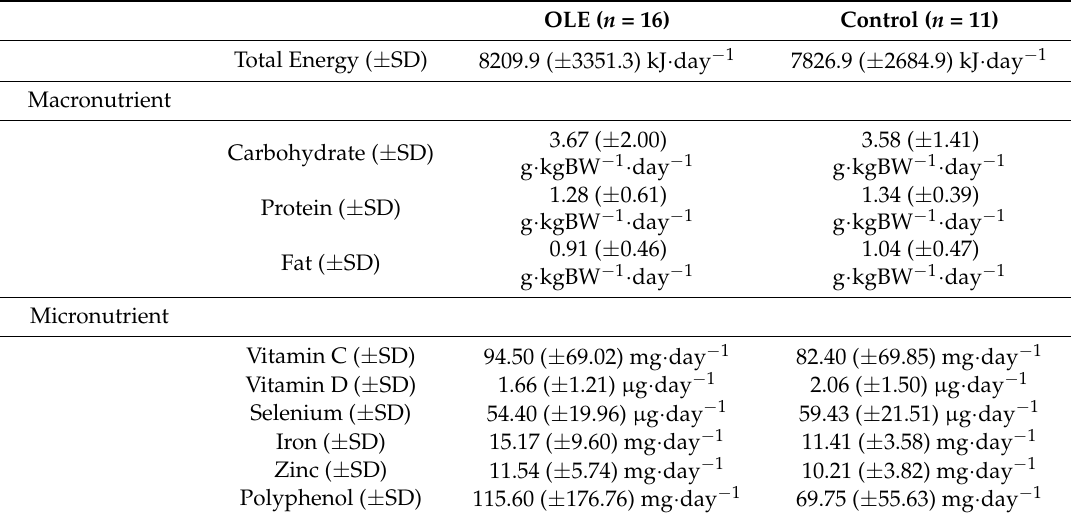
Table 3. Population characteristics of included